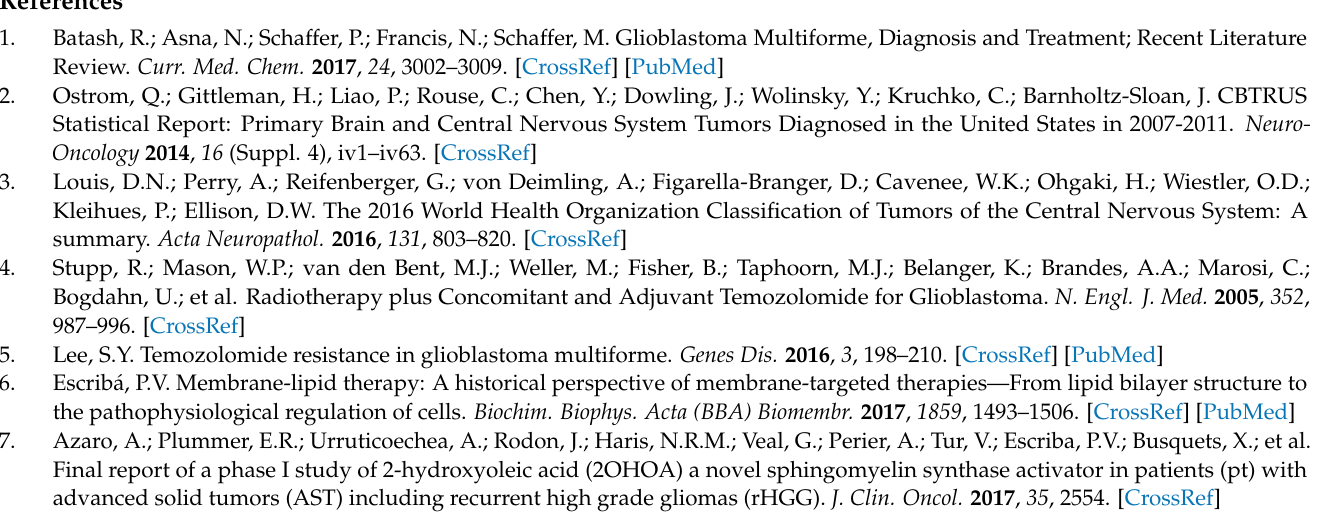
Figure S4: Effect of HCA on the fatty acid composition of U-118 MG or SF-295 GBM cells, Figure S5: Densitometric analysis of Western blot results presented all figures, Table S1: Efficacy of HCA against different human glioma cell